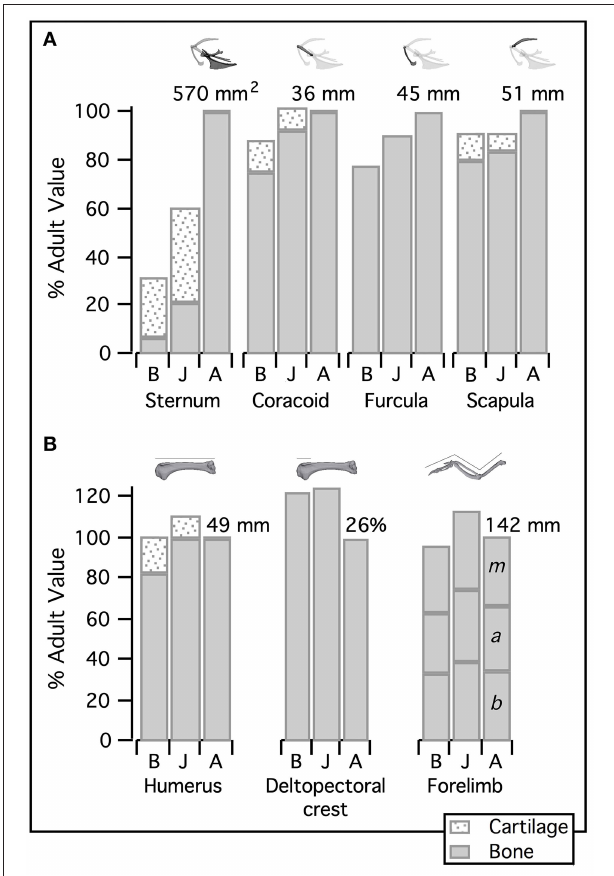
FIGURE 3 | Relative size of the flight apparatus. (A) Elements of the pectoral girdle become proportionally larger during avian ontogeny: bones are typically smallest in baby birds (though the scapula is equally small in juveniles) and largest in adults (though the coracoid reaches adult size in juveniles). (B) In contrast, humeral as well as total forelimb length peaks in juveniles, and the deltopectoral crest is proportionally longer in both immature age classes than in adults. Bone measurements first standardized by notarium length to determine proportions relative to body size, then standardized by adult values to assess the relative development of different components of the flight apparatus. Coracoid, furcula, scapula, humerus, and (total) forelimb quantified by length; deltopectoral crest quantified as a percentage of humeral length; keel of sternum quantified by area; adult values indicated above